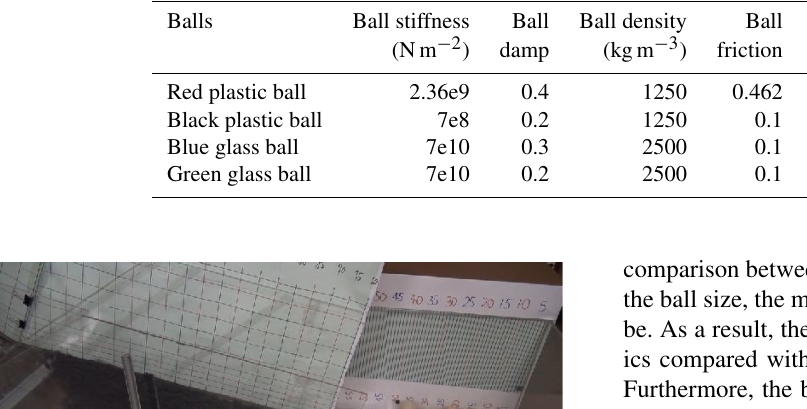
Table 3. Microscopic parameters of the balls for granular flow analysis.